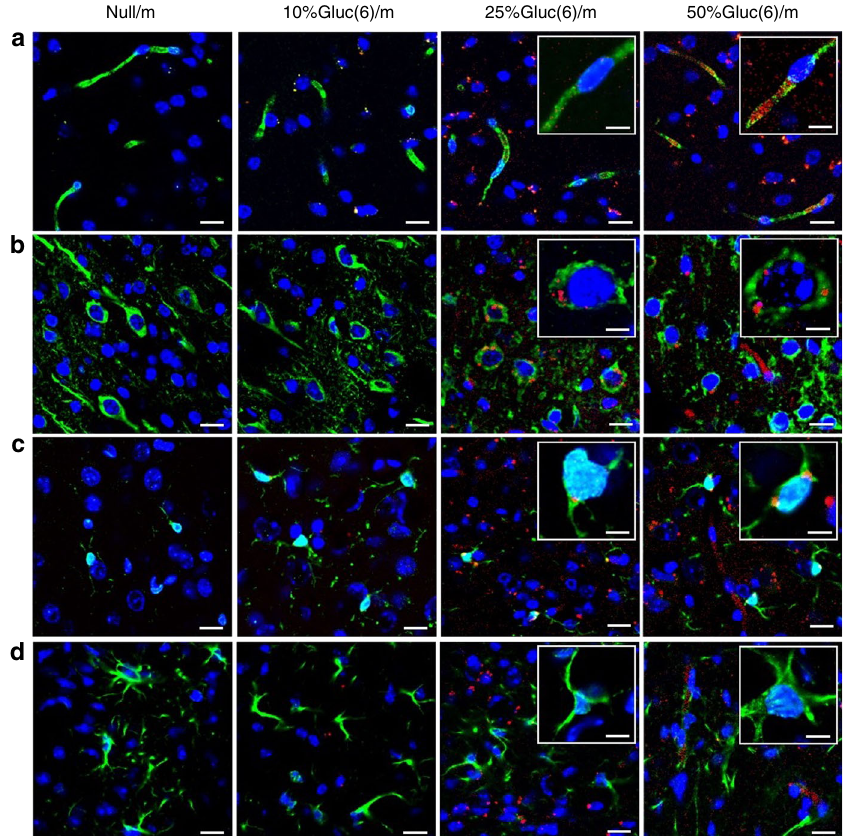
Fig. 4 Immunohistochemical analysis of the mouse brains after administration of polymeric micelles. Cerebral sections at 48 h after the administration of Null/m, 10%Gluc(6)/m, 25%Gluc(6)/m and 50%Gluc(6)/m (red). BCECs ( a ), neurons ( b ), microglia ( c ) and astrocytes ( d ) (green) are stained with anti- PECAM1, anti-Tuj1, anti-Iba1 and anti-GFAP antibodies, respectively. Nuclei (blue) are stained with DAPI. The scale bar indicates 20 μ m (10 μ m in